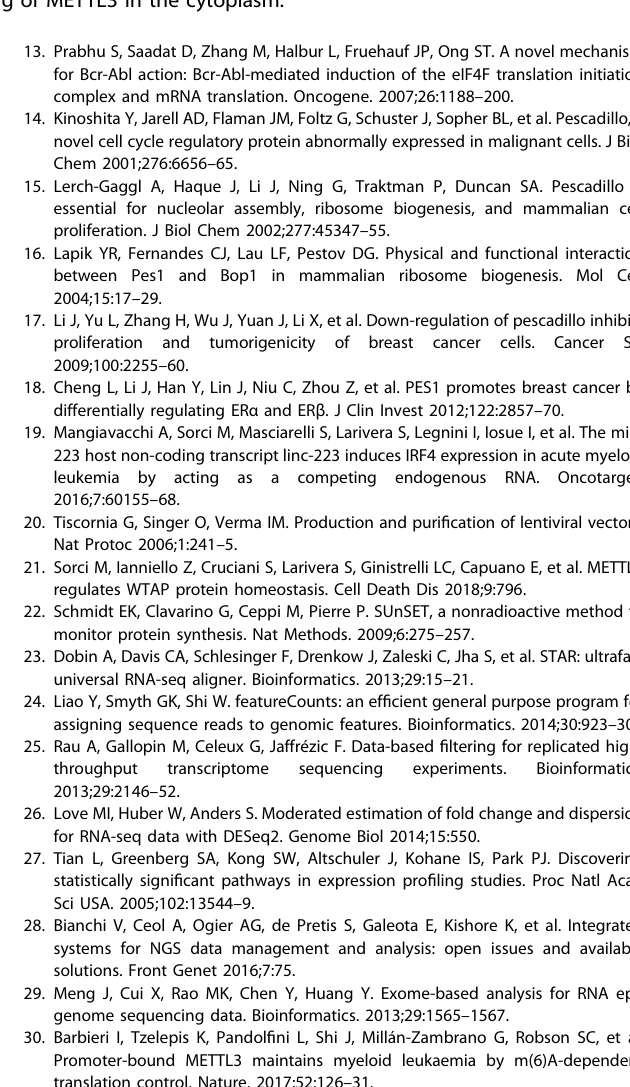
Fig. 8 Schematic model for the role of METTL3 and METTL14 in CML. METTL3 acts in the nucleus in combination with METTL14 to modify nascent transcripts whose translation can be enhanced by the binding of METTL3 in the